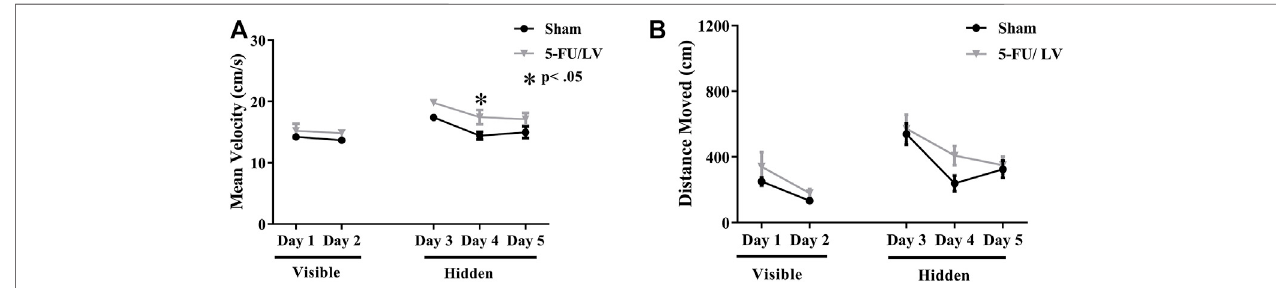
Frontiers in Molecular Biosciences |